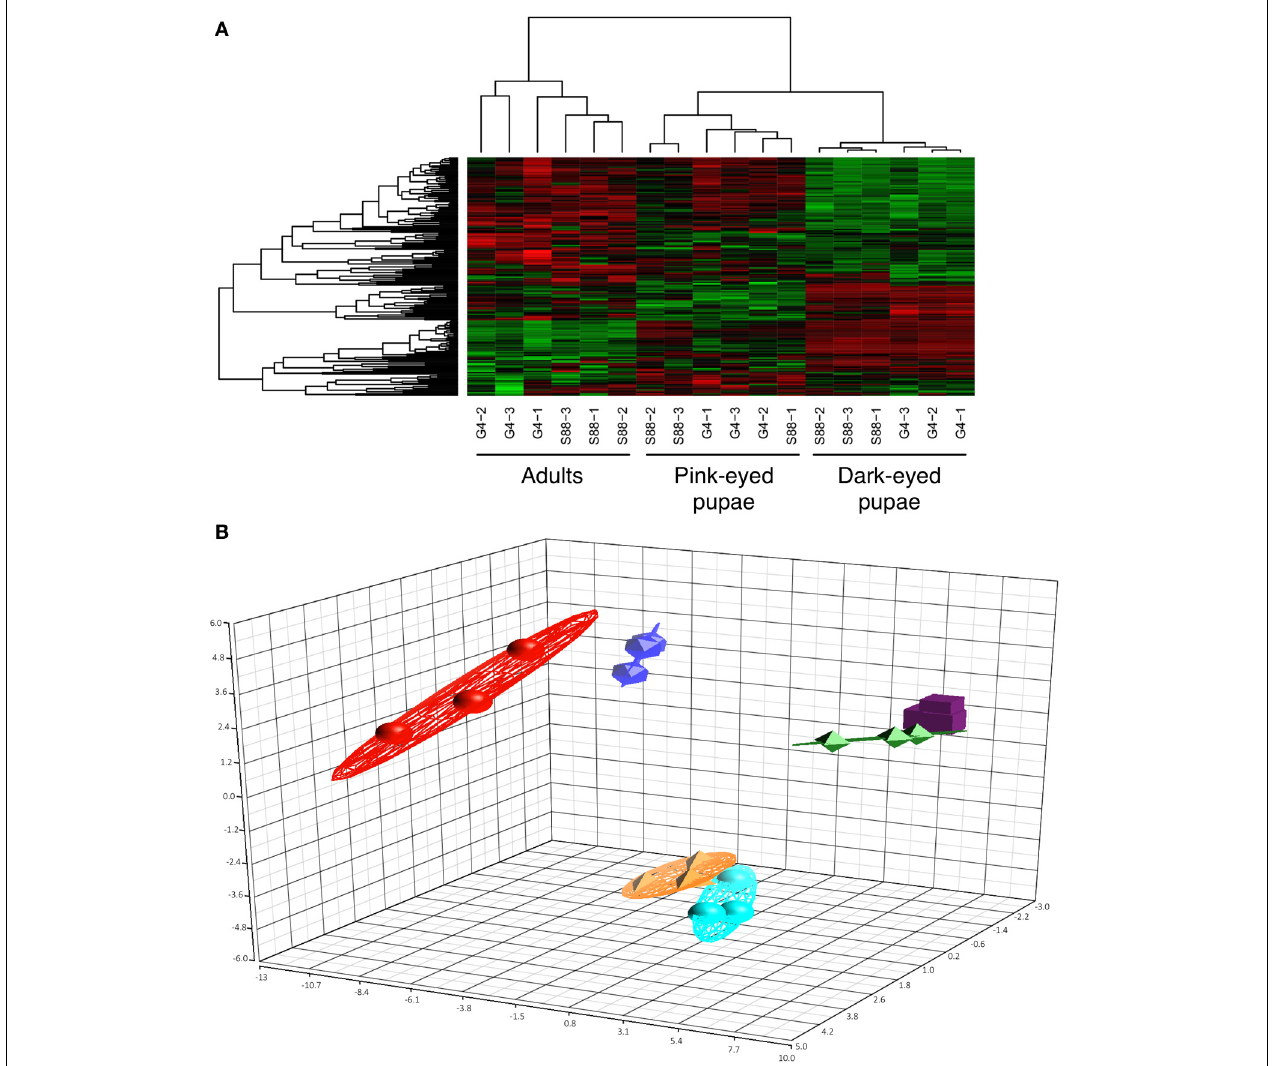
FIGURE 3 | Clustering of the kinome profiles of bees of different phenotypes at different developmental stages. (A) Hierarchical clustering of kinome datasets. (1 − Pearson correlation) was used as the distance metric, while McQuitty linkage was used as the linkage method. Each column represents the kinome activity of individual bees ( n = 3/treatment). The kinome profiles of the bees segregated first by developmental stage and then largely by colony phenotype (S88: resistant; G4: susceptible). Colors indicate the average (over nine